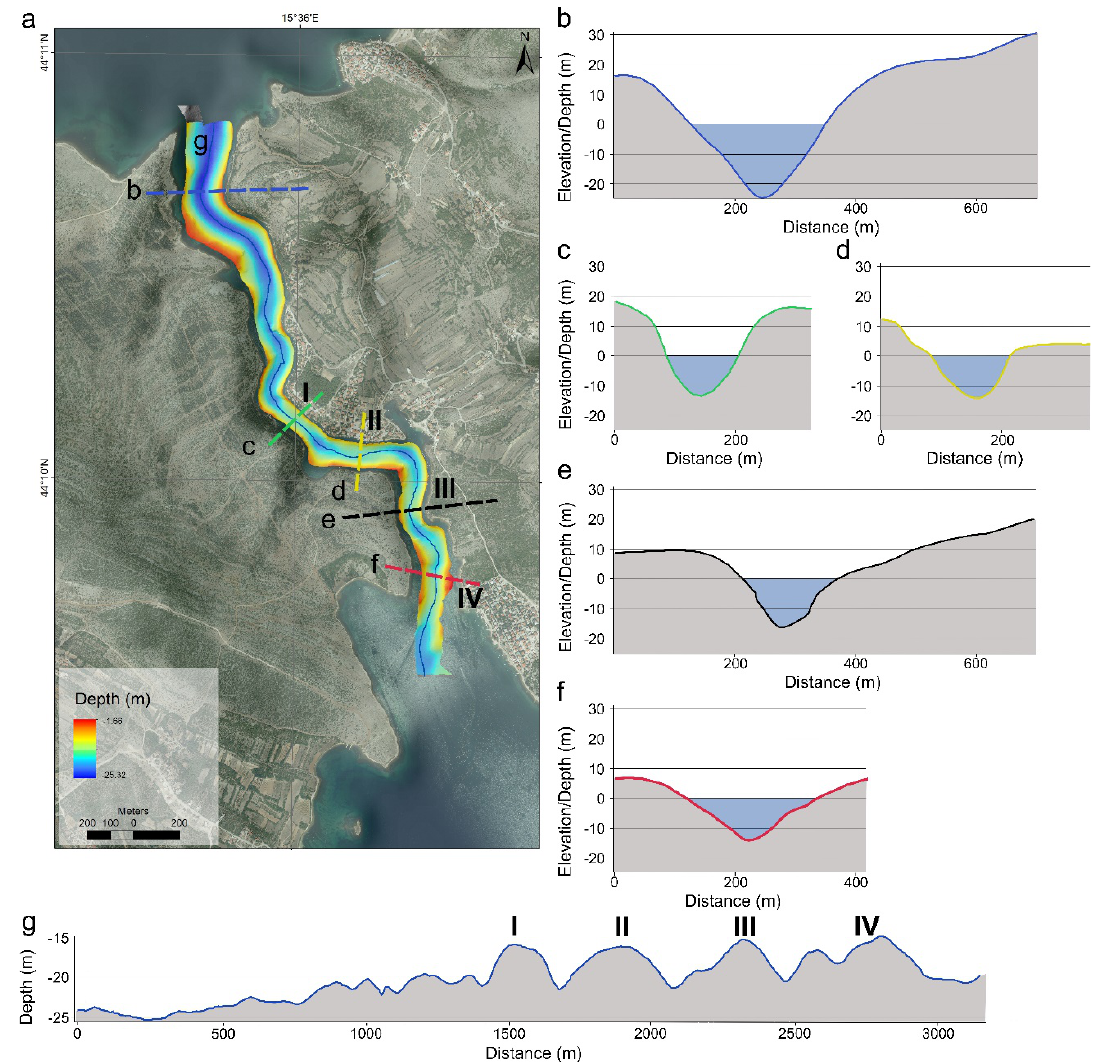
Figure 3. ( a ) MBES bathymetry image of KZD draped over the DTM and orthophoto image [27]. Prominent barriers are marked with numbers I-IV. ( b – f ) Profiles showing the barriers and deepest parts of KZD canyon with depths of 25 m and elevations up to 40 m a.s.l. ( g ) The lowest profile through KZD showing a possible path of water flow (out of and into the Novigrad Sea) during the lowstand and sea-level rise. The barriers from ( a ) are marked with numbers I-IV.